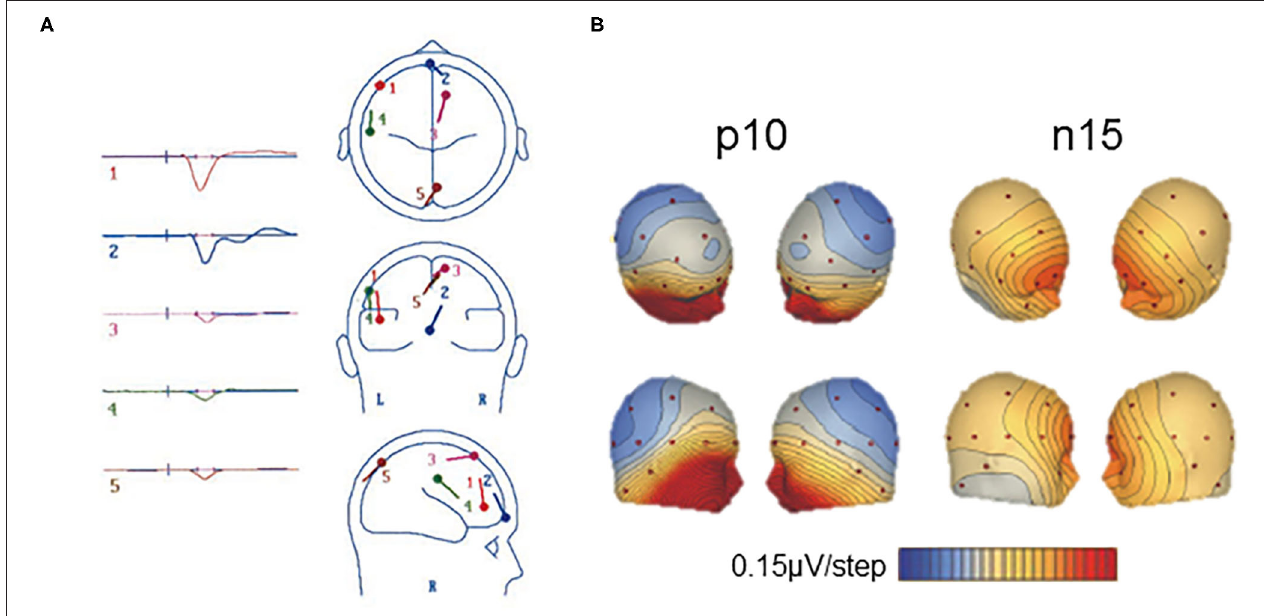
FIGURE 3 | Short latency vestibular-evoked cerebral potentials (VestEPs). (A) Source dipole analysis of grand average VestEPs with latencies under 10ms. VestEPs were triggered by electrical stimulation of the vestibular nerve during surgery. Five dipoles were identified and localized: dipole 1 (red) is at the limit of the ipsilateral frontal and prefrontal lobes, dipole 2 (blue) is on the transverse frontopolar and/or frontomarginal gyrus of the prefrontal lobe, close to the midline, dipole 3 (pink) is on the contralateral anterior portion of the supplementary motor area (around the supplementary eye fields); dipole 4 (green) is on the ipsilateral temporoparietal area; dipole 5 (brown) is on the contralateral superior occipital gyrus, although close to the midline. Adapted from ( 133) with permissions from Springer Nature. (B) Voltage maps of the p10 and n15 evoked by left sound-induced vestibular stimulation. Positive potentials are indicated in blue and negative in red and contours are spaced at 0.15 µ V. Adapted from (108) with permissions from